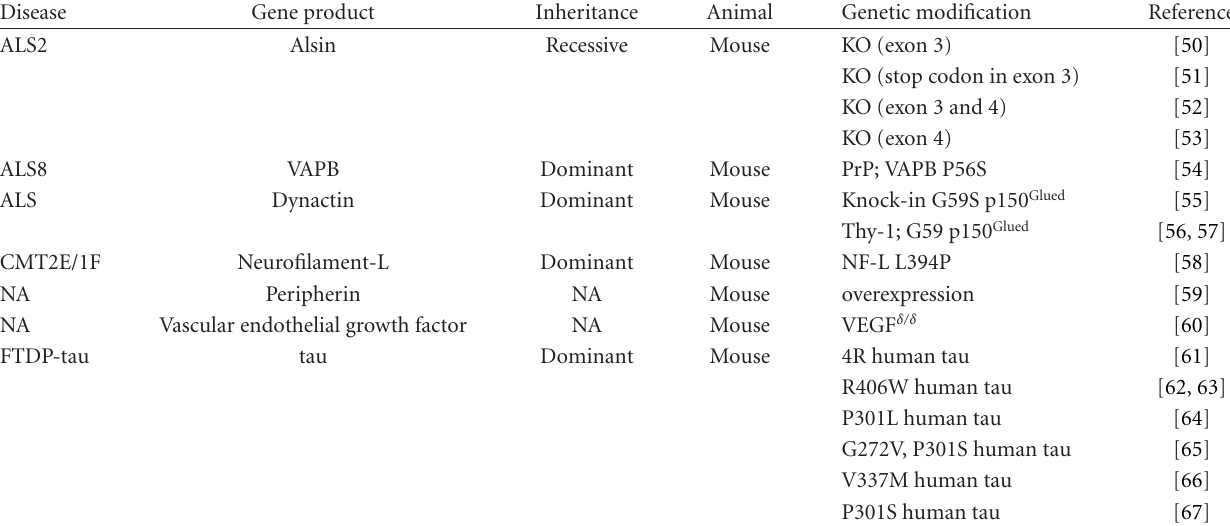
Table 3: Overview of transgenic mouse models for motor neuron degeneration (atypical or rare FALS and candidate genes).